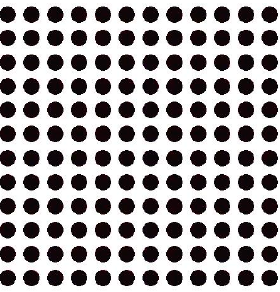
Figure 13. The results of segmentation.